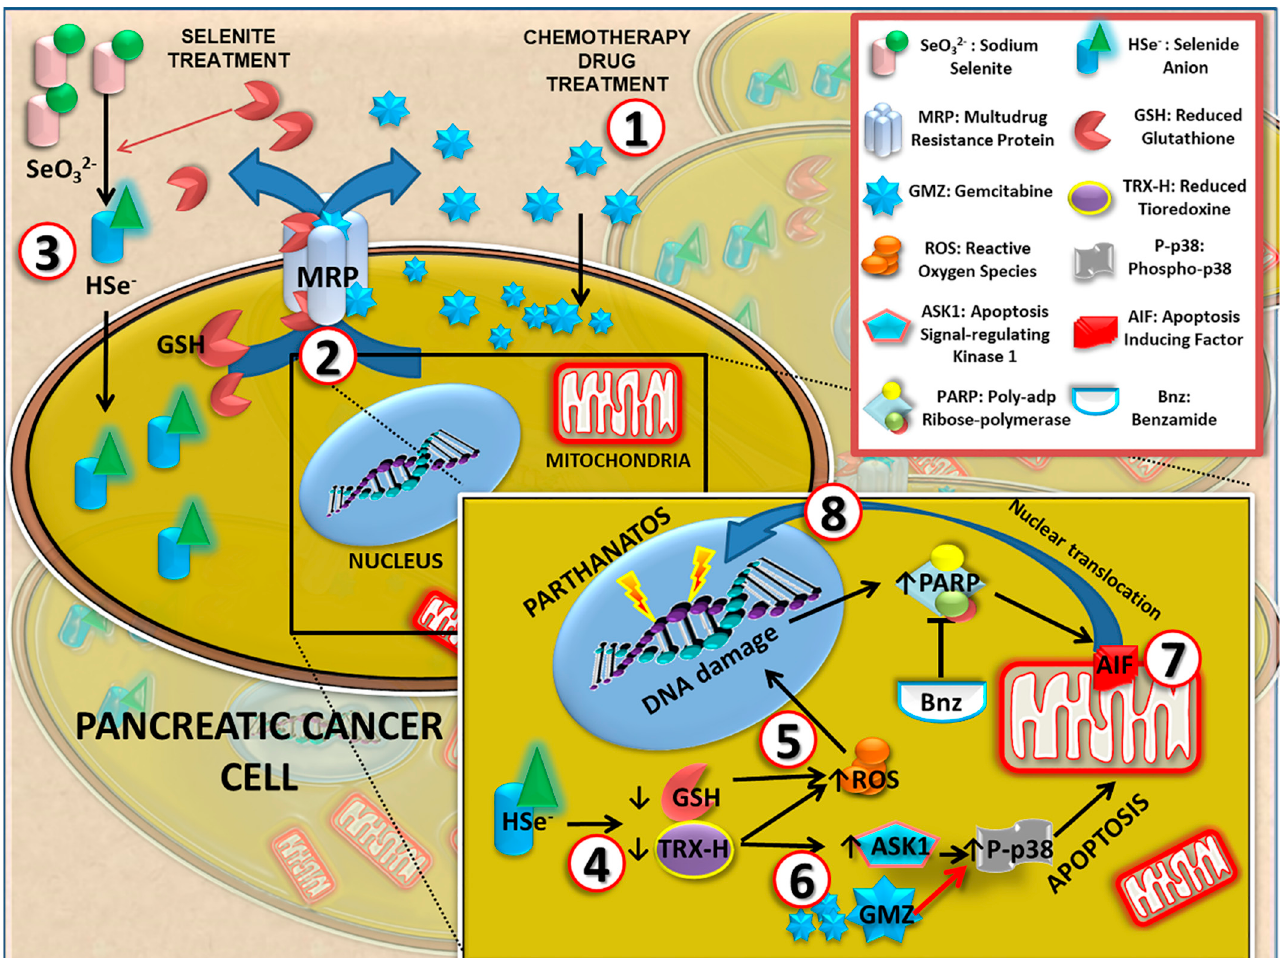
Figure 8. Molecular mechanisms involved in the anticancer activity of sodium selenite in pancreatic cancer cells. This model summarizes the mechanisms by which selenite can induce cell death in tumor cells and hypothesizes about the enhanced antitumor effect found when selenite and gemcitabine were associated. (1). Gemcitabine (GMZ) enters the cell cytoplasm. (2). GMZ is detoxified by MRP system conjugated with reduced glutathione (GSH). (3). Specifically, sodium selenite (SeO 3 2- ) is reduced to selenide (HSe - ) by GSH, which is expelled due to cellular detoxification processes via the MRP system. (4). Once inside the cell cytoplasm, selenite depletes GSH and reduced thioredoxin (TRX-H), leaving the cell defenseless against reactive oxygen species (ROS) and increasing them. (5). ROS cause DNA damage, which is repaired by poly-ADP-ribose polymerase (PARP), resulting in overexpression of this enzyme. Benzamide (Bnz) inhibits PARP as well as the subsequent processes of repair and cell death induced by this enzyme. (6). GMZ is a chemotherapeutic agent that induces apoptosis via phospho-p38 activation. As shown in the figure, SeO 3 2- decreases TRX-H and releases the ASK1 factor, which phosphorylates p38. The synergy between GMZ and SeO 3 2- could be related to the latter mechanism. (7) and (8). The accumulation of DNA damage due to ROS activates PARP to initiate the translocation of apoptosis-inducing factor (AIF) from the mitochondria to the cell nucleus, inducing cell death by parthanatos.